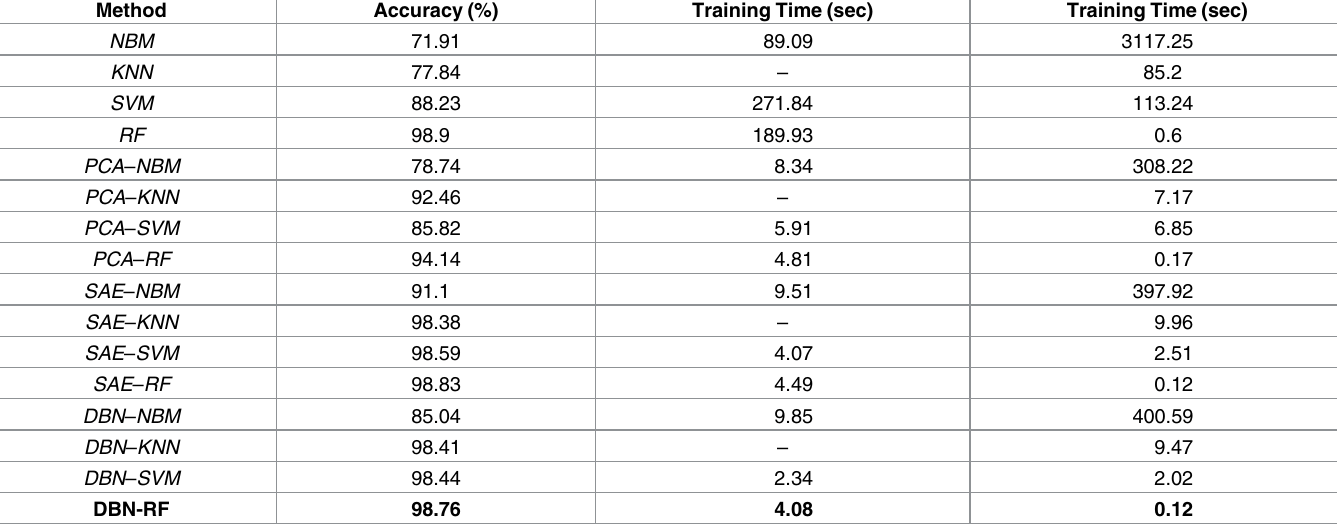
Table 1. Comparison of the training time and forecasting accuracy(training 20%, testing 80%).